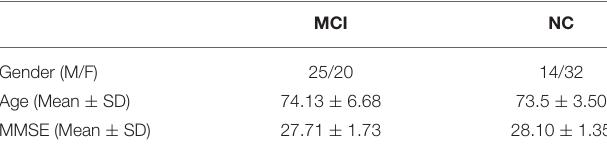
TABLE 1 | Demographic information of